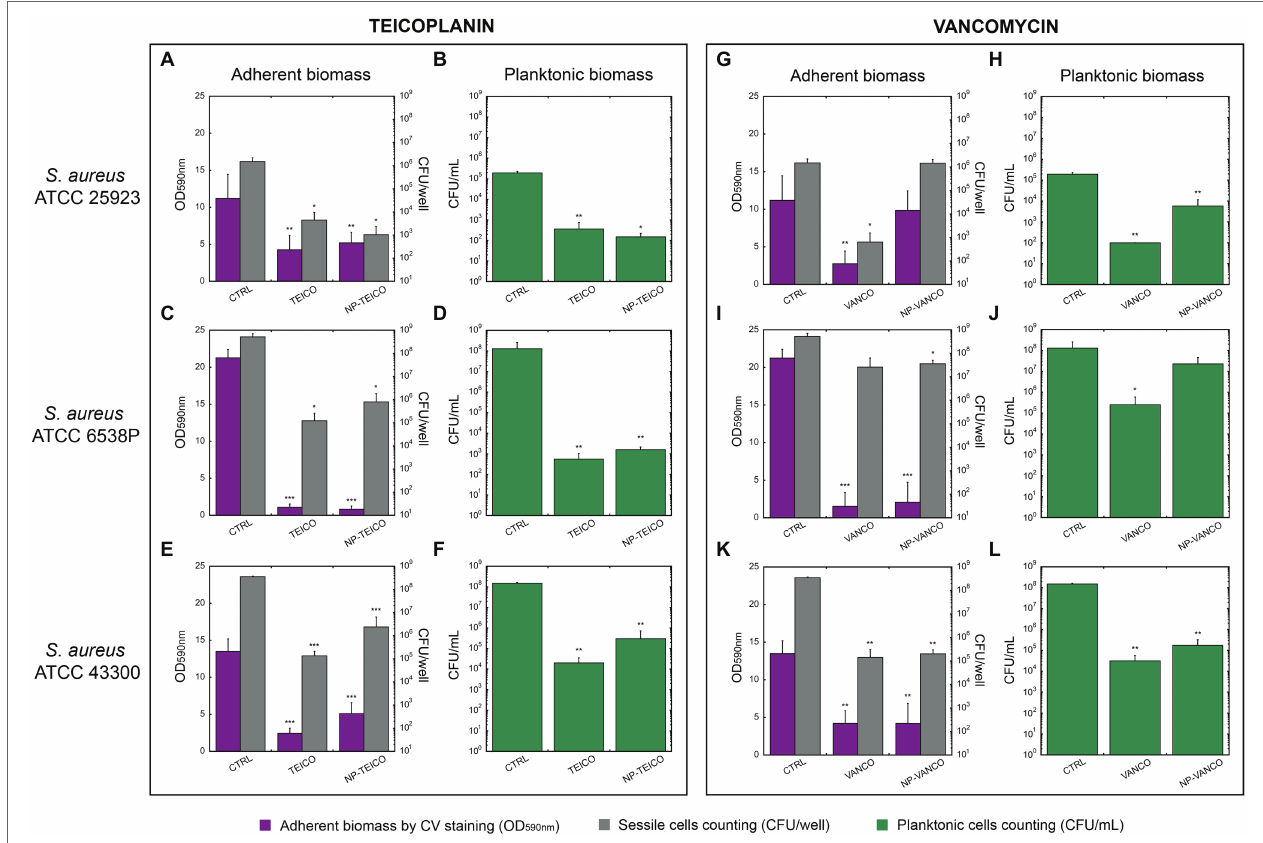
FIGURE 3 | Inhibition of biofilm formation in three S. aureus strains by nonconjugated and nanoconjugated teicoplanin or vancomycin. In all panels, ‘CTRL’ refers to the untreated control. Panels A and B : effect of nonconjugated or nanoconjugated teicoplanin at 1 μ g/ml on biofilm formation by S. aureus ATCC 25923 grown for 48 h. Panels C and D : effect of nonconjugated or nanoconjugated teicoplanin at 4 μ g/ml on biofilm formation by S. aureus ATCC 6538P grown for 24 h. Panels E and F : effect of nonconjugated or nanoconjugated teicoplanin at 8 μ g/ml on biofilm formation by S. aureus ATCC 43300 grown for 24 h. Panels G and H : effect of nanoconjugated and nonconjugated vancomycin at 1 μ g/ml on biofilm formation by S. aureus ATCC 25923 grown for 48 h. Panels I and J : effect of nanoconjugated and nonconjugated vancomycin at 4 μ g/ml on biofilm formation by S. aureus ATCC 6538P grown for 24 h. Panels K and L : effect of nanoconjugated and nonconjugated vancomycin at 16 μ g/ml on biofilm formation by S. aureus ATCC 43300 grown for 24 h. Adherent biomass is estimated spectrophotometrically at 590 nm after crystal violet staining (violet bars in A,C,E,G,I,K ) and by bacterial cell counting of sessile cells expressed as CFU/well (grey bars in A,C,E,G,I,K ). Cellular concentration (CFU/ml) of planktonic population was also evaluated (green bars in B,D,F,H,J,L ). The values are the means of at least three independent experiments and the bars represent standard deviations. Statistical analyses were performed by one-way ANOVA (* p < 0.05; ** p < 0.01; *** p <